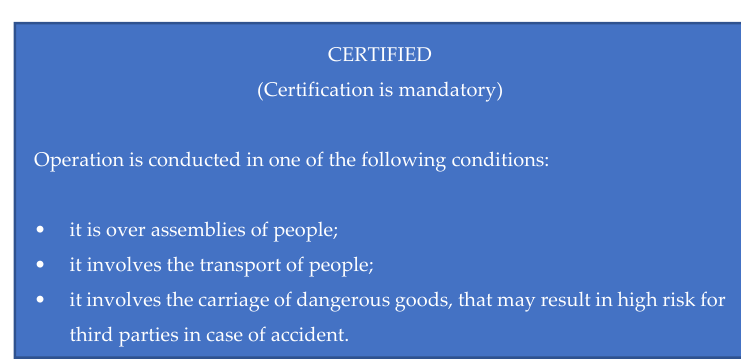
Figure 5. Constraints for the specific category.